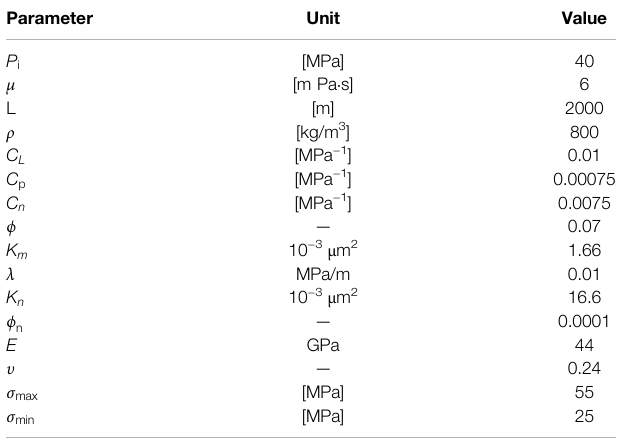
TABLE 1 | Basic parameters of tight reservoir used in calculation.